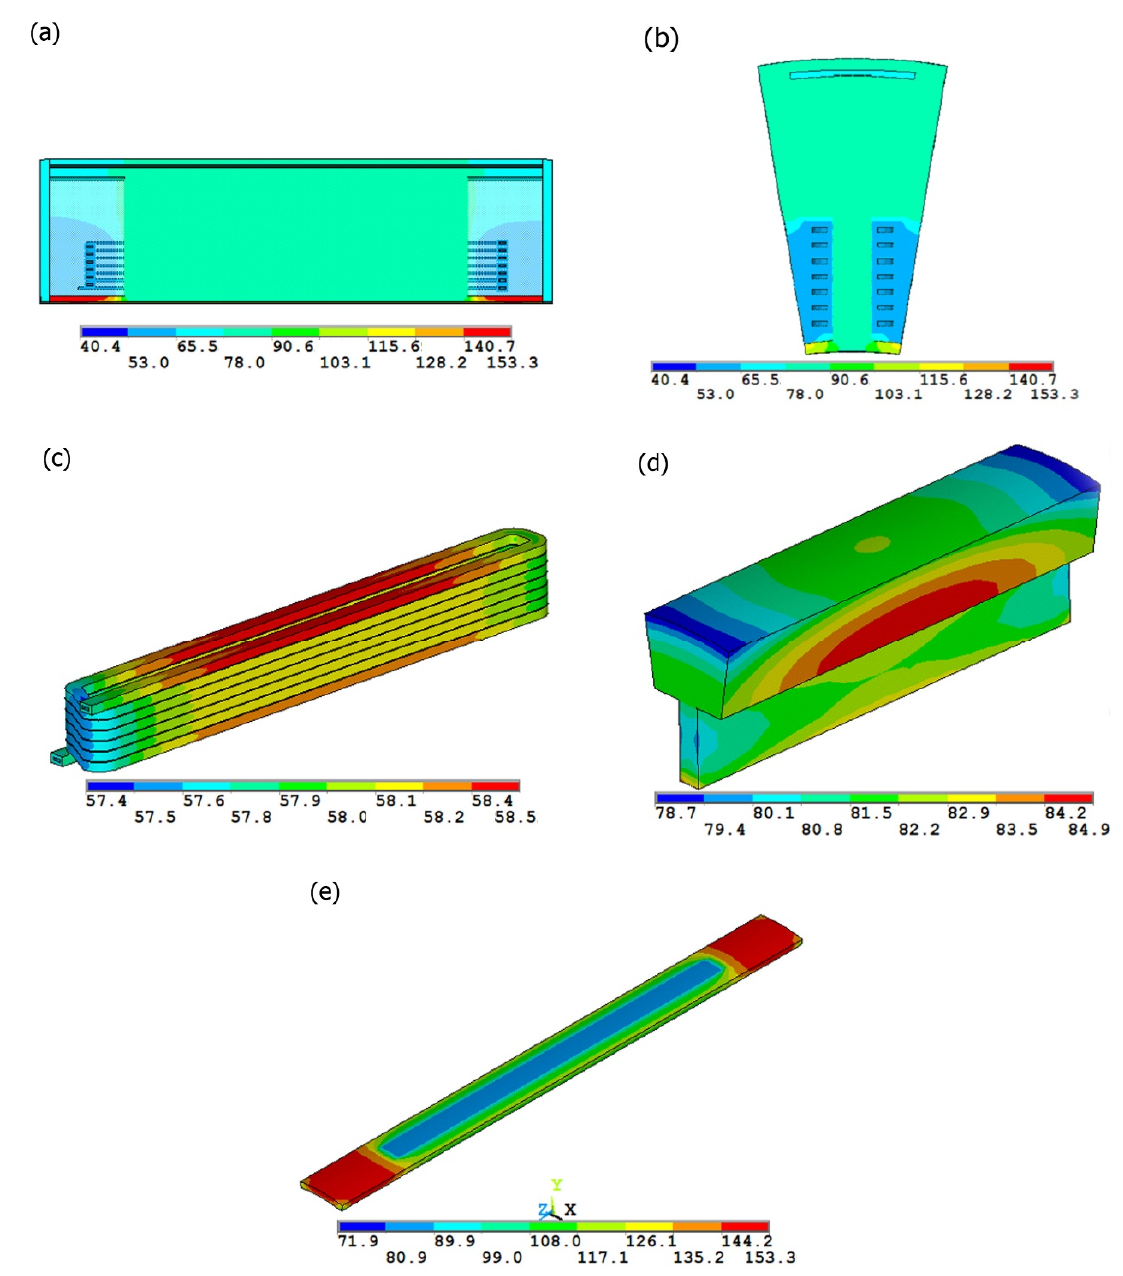
Figure 4. Results of calculation of the EMM field temperature (°C): ( a ) axial section; ( b ) cross-section; ( c ) coil; ( d ) core; and ( e ) working chamber.